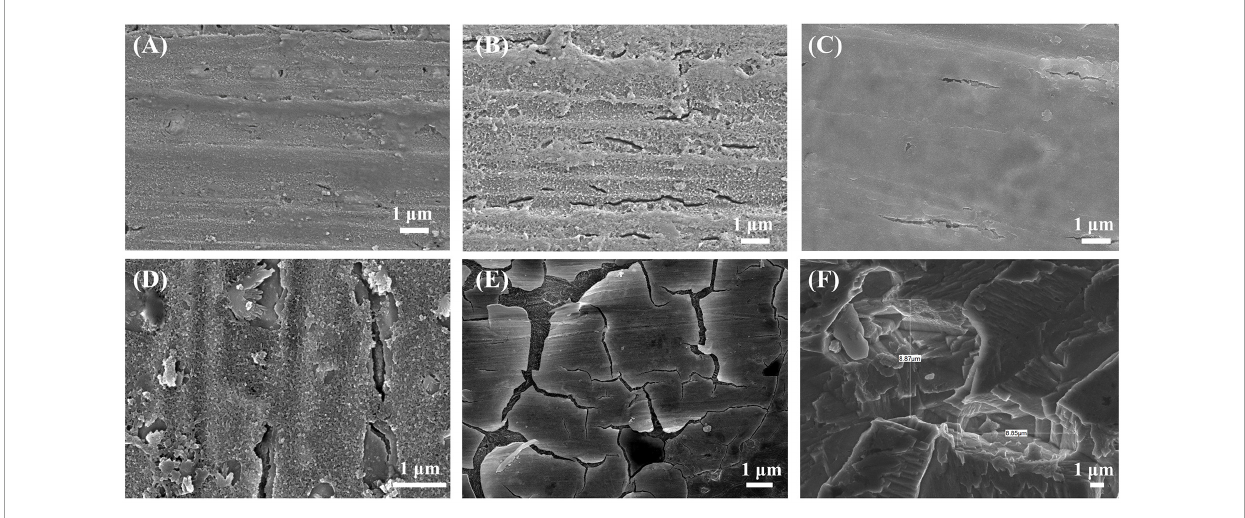
FIGURE5 Corrosion morphology of B30 copper–nickel alloy after immersion in the abiotic medium for (A) 7 days and (B) 14 days and in P. aeruginosa for (C) 7 days, (D) 14 days, and (E) 21 days; (F) substrate after immersion for 21 days to remove corrosion products.